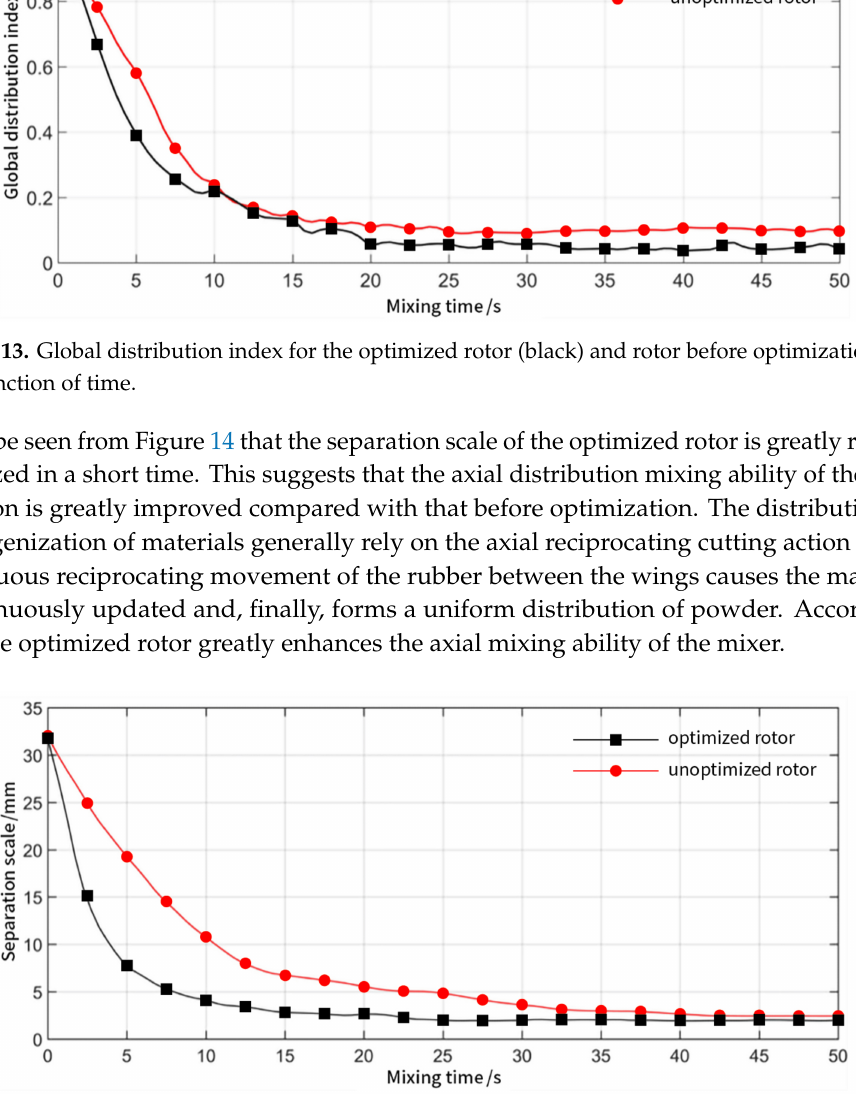
Figure 14. Separation scale as a function of time curve of distributed mixing between two internal mixer chambers for the optimized rotor (black) and rotor before optimization